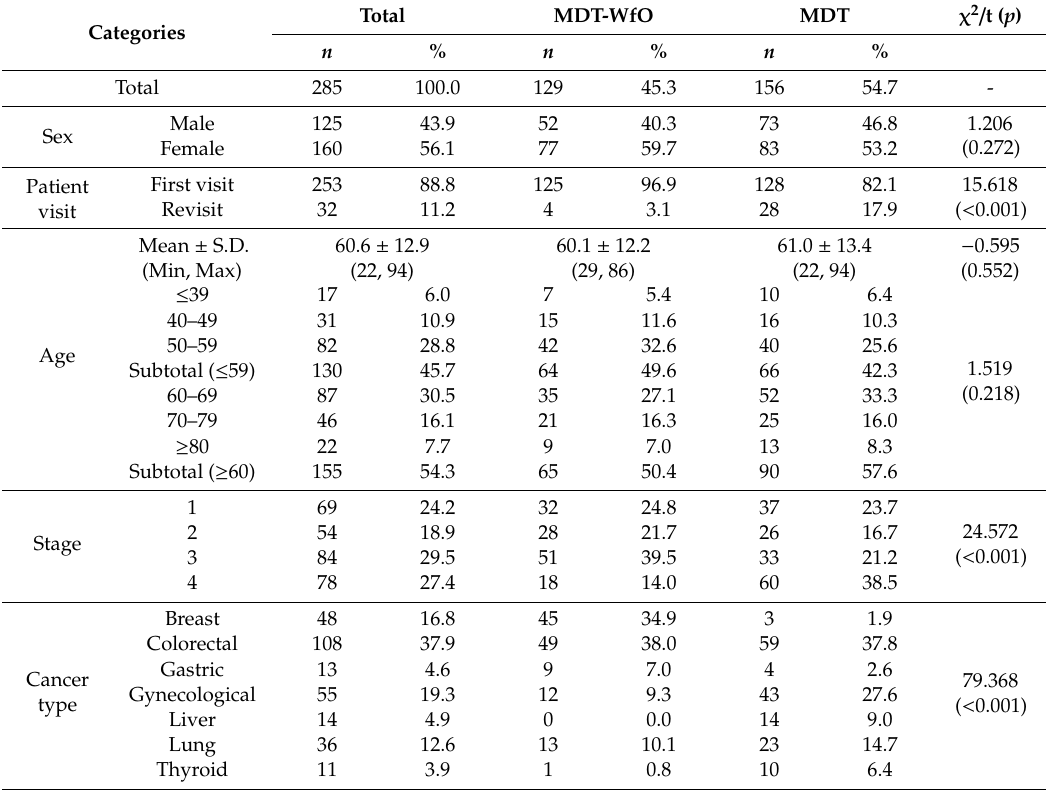
Table 1. General characteristics of